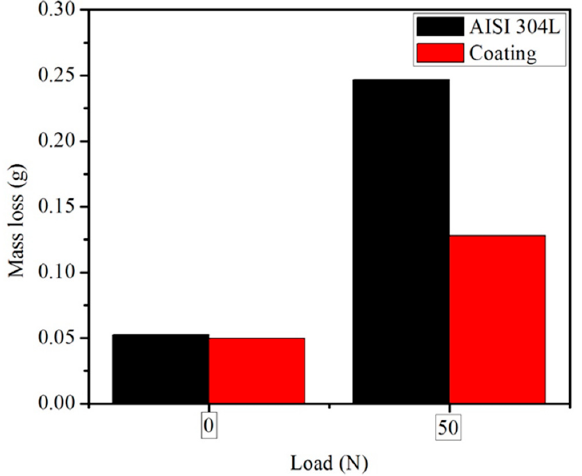
Figure 11. Mass loss of specimens of AISI 304L stainless steel as a function of load applied after pin-on-disk wear testing: uncoated (black bars) and coated with α -Al 9 FeMnSi (red bars).